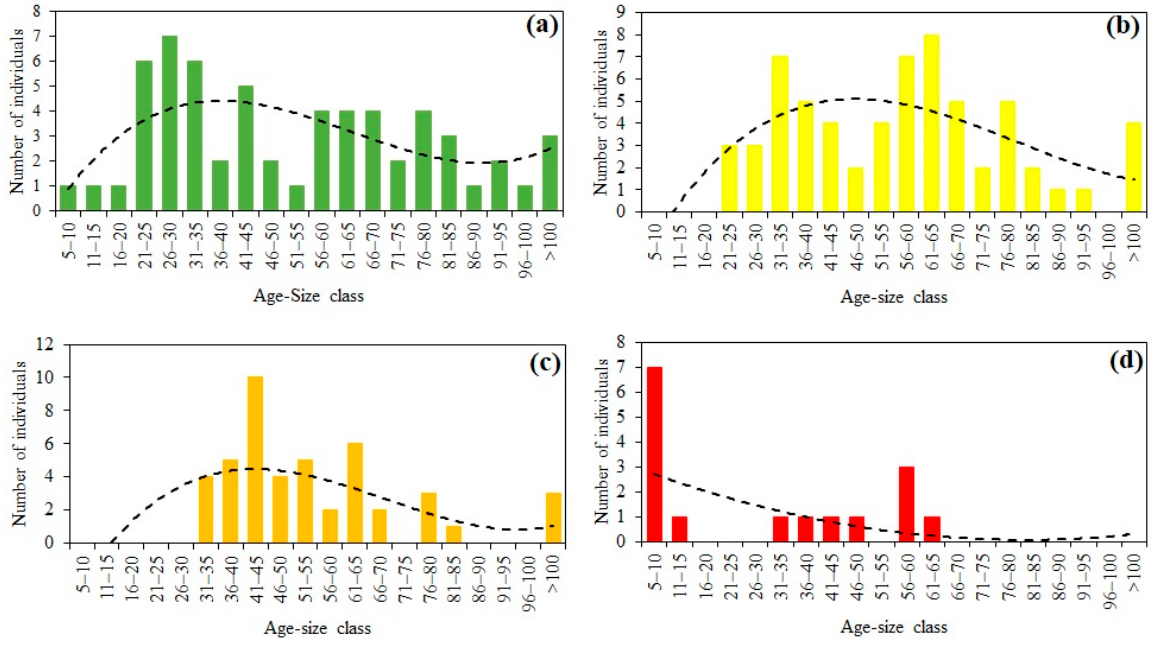
Figure 7. Tree age structure by severity levels ( a ) unburned areas, ( b ) areas affected by low fire severity, ( c ) areas affected by medium or moderate fire severity, and ( d ) areas affected by high fire severity .